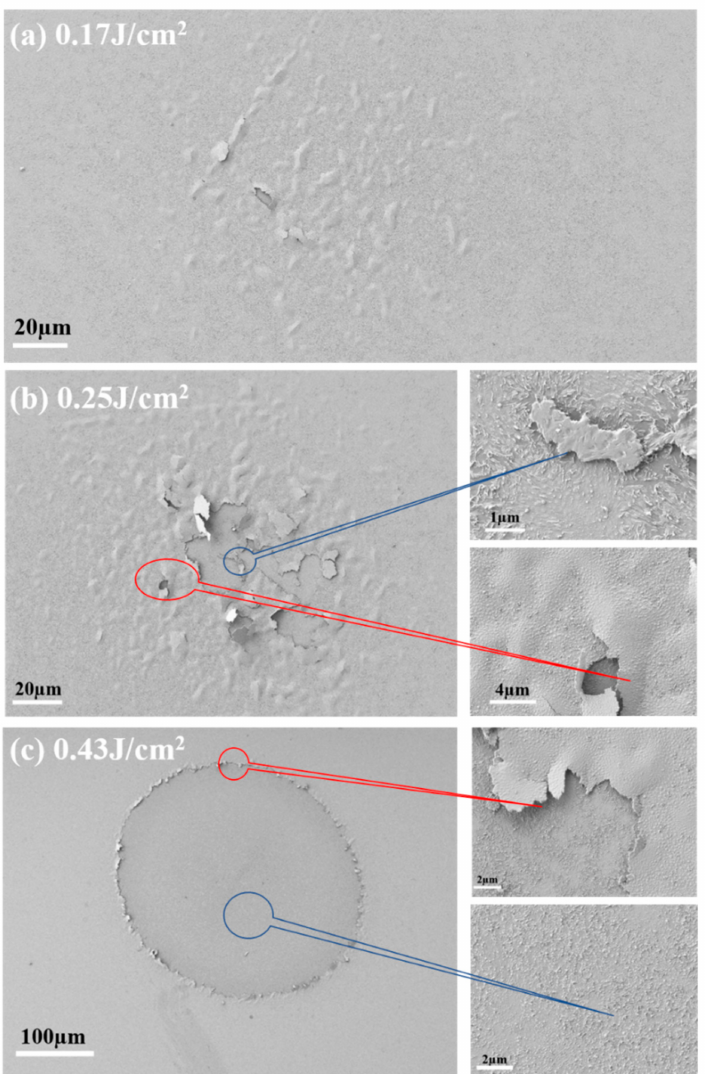
Figure 11. SEM morphologies of the W-doped VO 2 film under different fluence levels of ( a ) 0.17, ( b ) 0.25, and ( c ) 0.43 J/cm 2 . The right-hand subfigures in ( b , c ) are partial enlarged